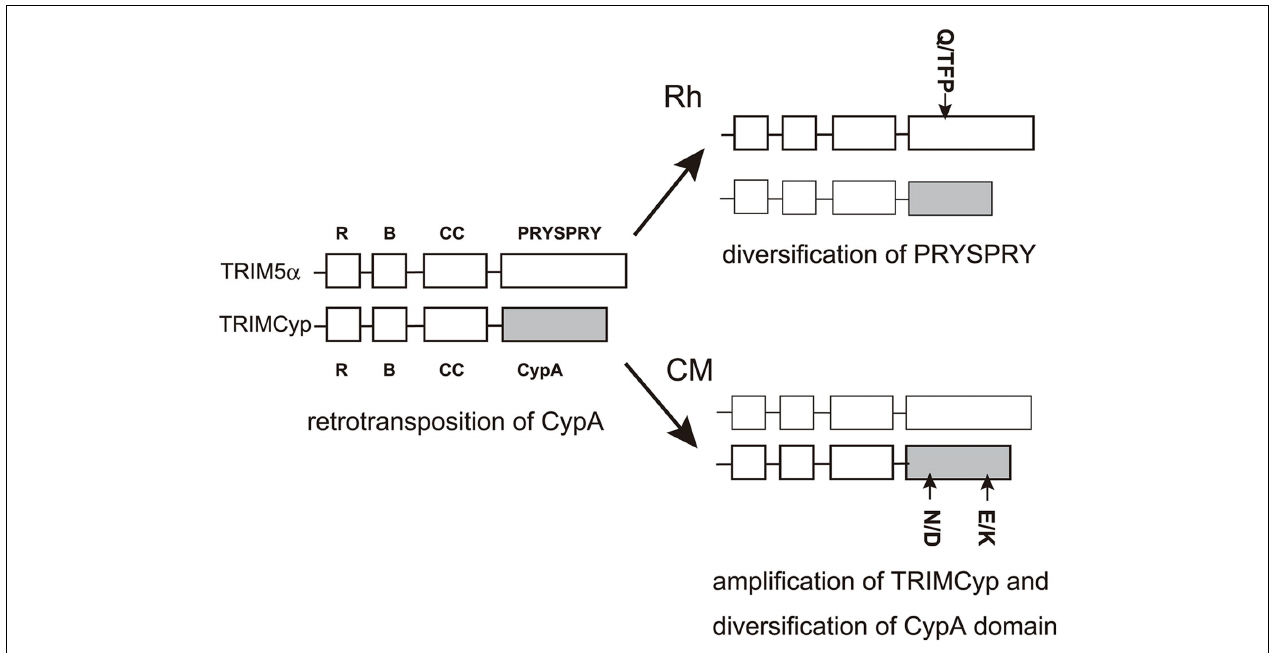
FIGURE 7 | Diversity of Rh and CM TRIM5 genes. The RING, B-box2, Coiled-coil, and PRYSPRY domains ofTRIM5 α andTRIMCyp are shown by squares. CypA domains inTRIMCyp are shown as filled squares. Major alleles in Rh and CM are shown in bold lines. Polymorphisms are shown outside the